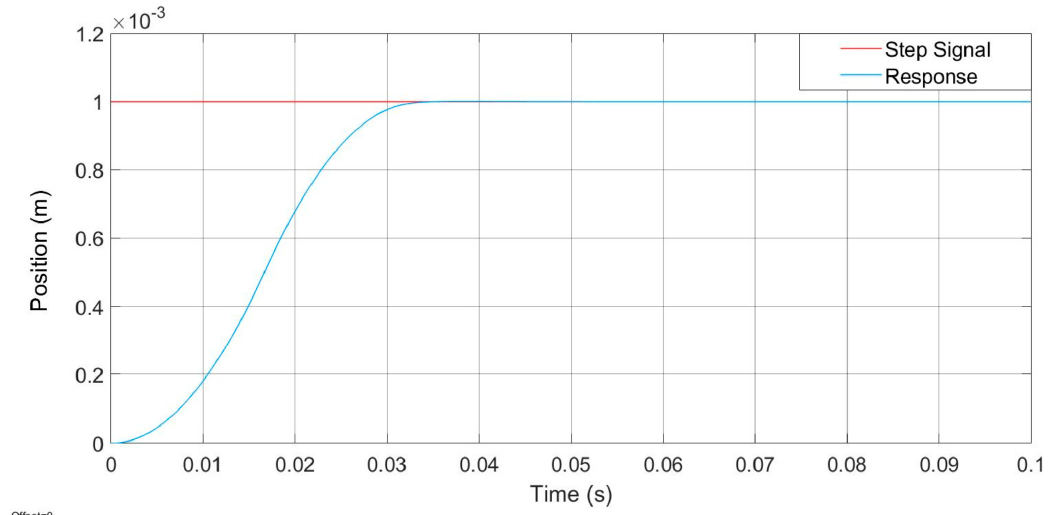
Figure 13. System response time to the step signal.